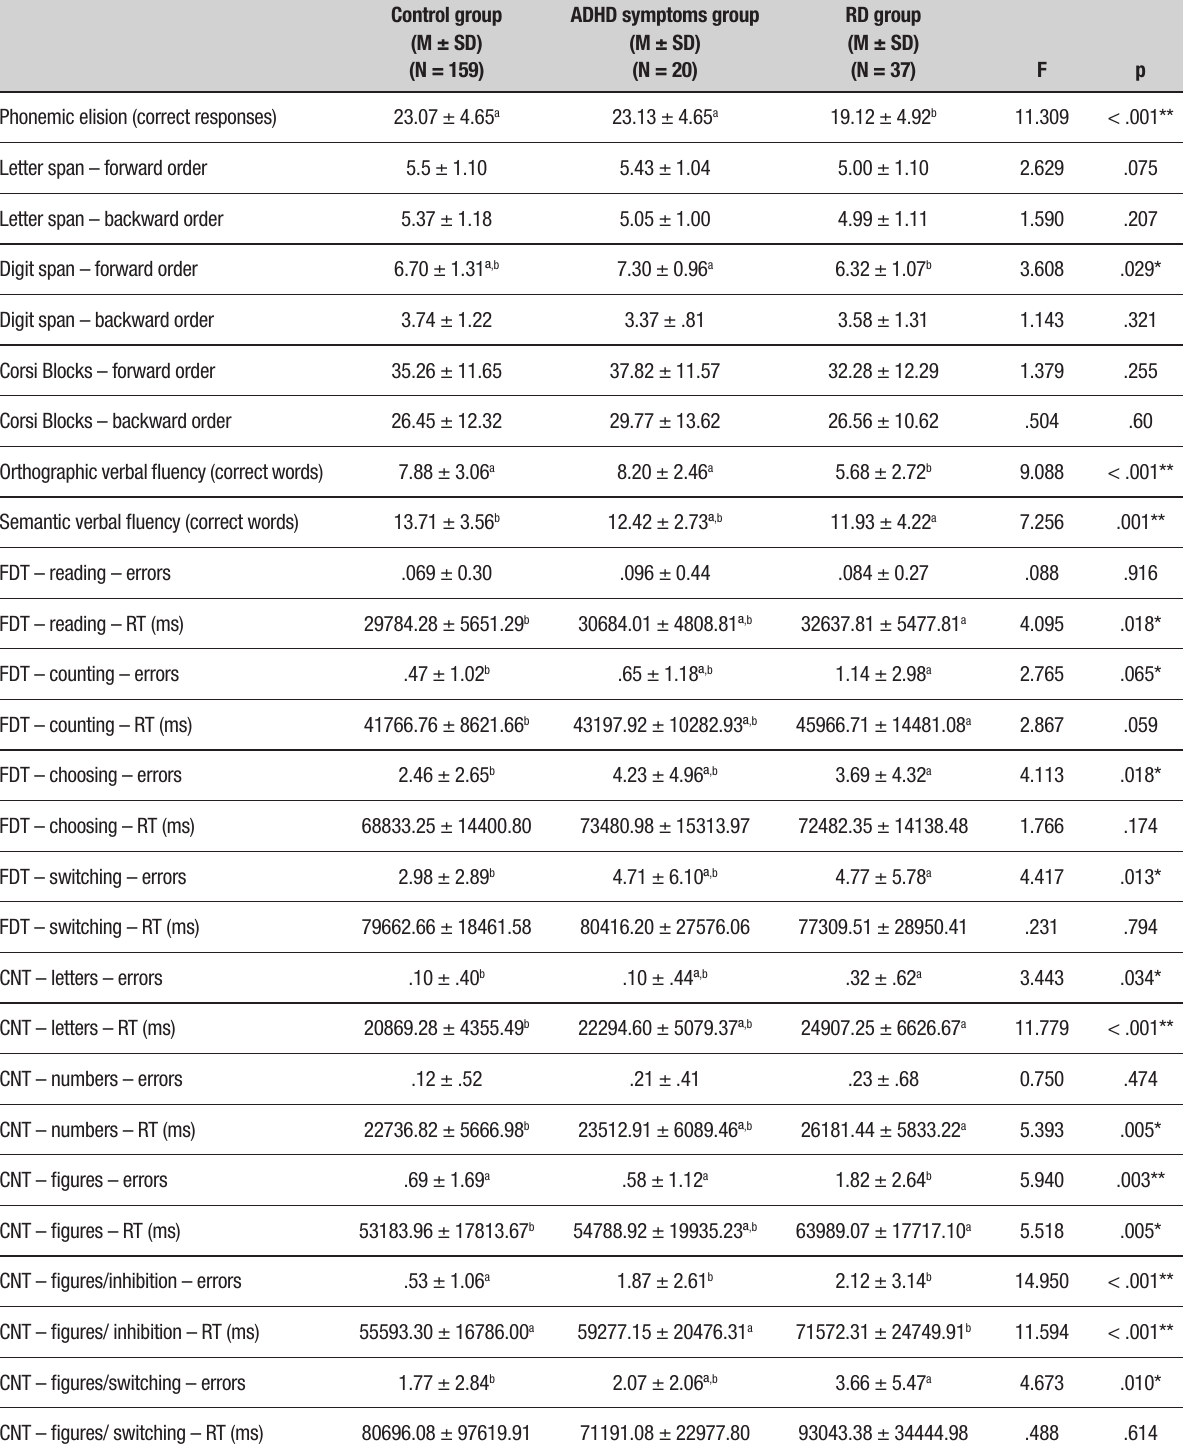
Table 2. MANOVA results for the neuropsychological variables, controlling for age and nonverbal IQ. Control